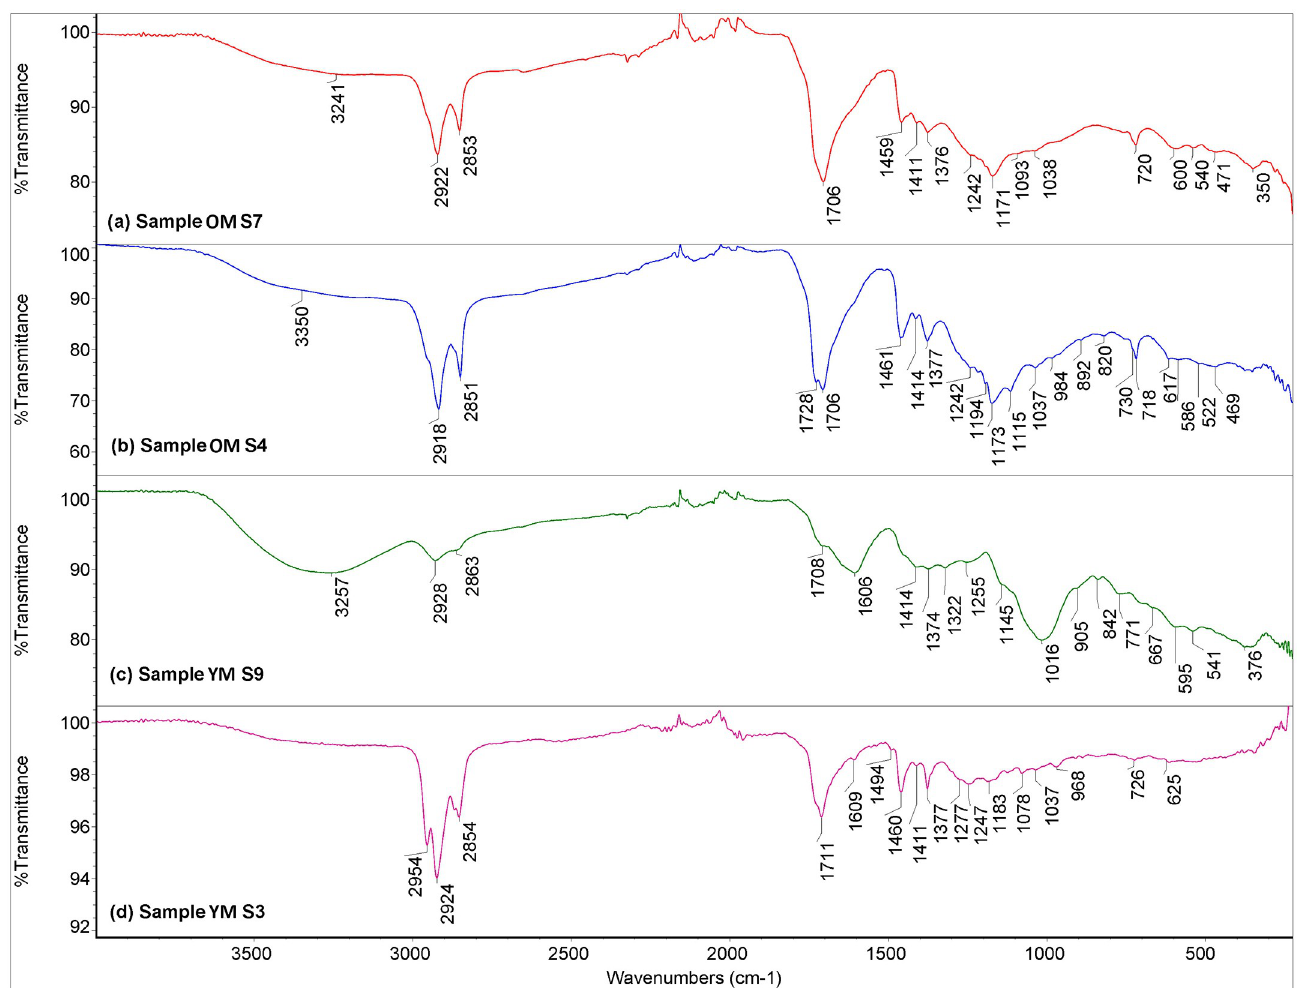
Fig 5. Selection of ATR-FT-IR spectra of embalming and textile impregnating materials. A—Material from the older mummy’s left foot (OM S7); B—Material from the older mummy’s abdominal cavity (OM S4); C—Material from the younger mummy’s hair (YM S9); D—Textile-impregnating material from the younger mummy (YM